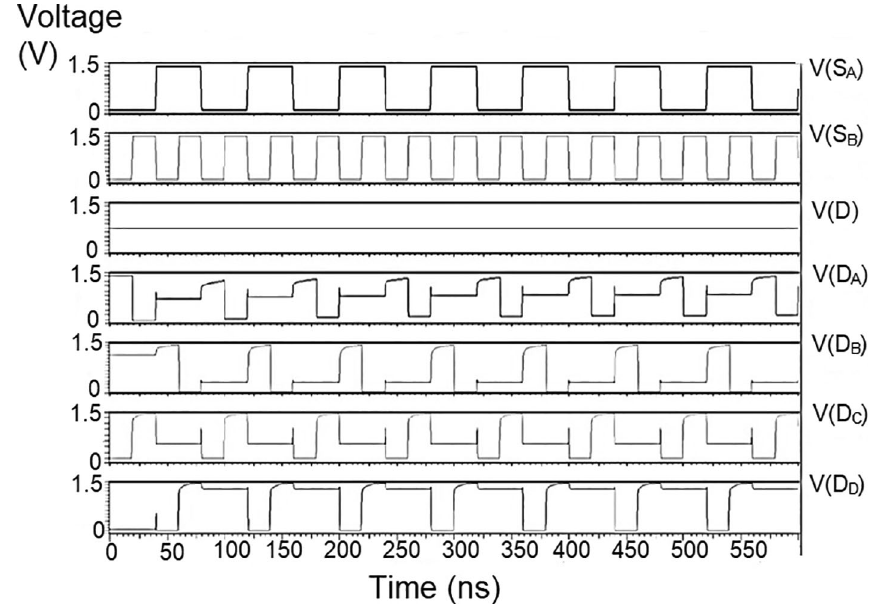
Figure 5(c). Voltage vs time simulation at 1.5 V for 180